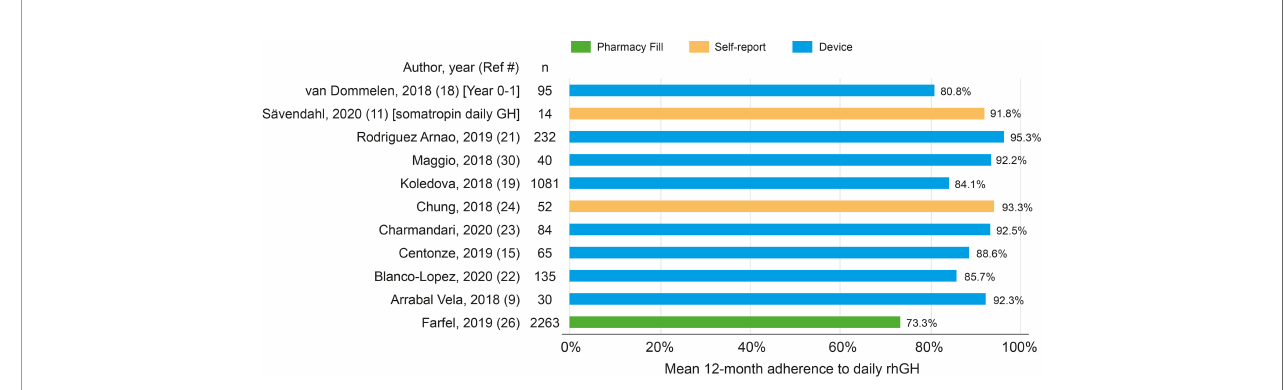
FIGURE 2 | Mean 12-month adherence among 11 rhGH studies. rhGH, recombinant human growth